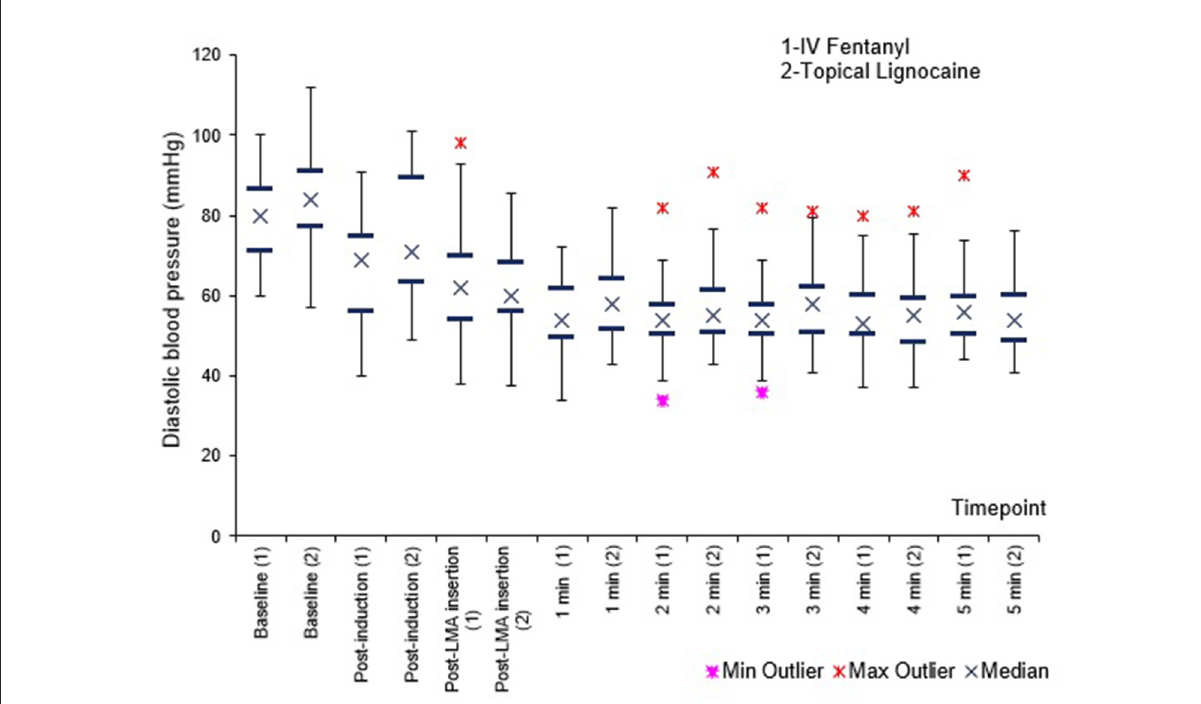
FIGURE2 Diastolic blood pressure (DBP) before, immediately after, and 1–5min after PLMA insertion. Results presented as median, 25 and 75th percentile, minimum and maximum